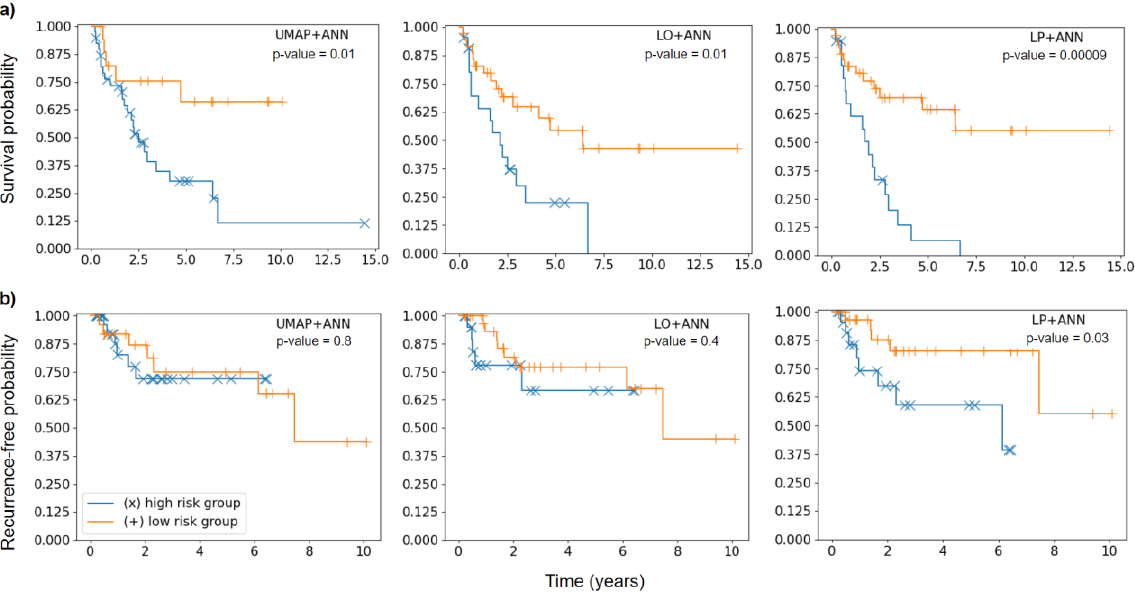
Figure 1. Kaplan-Meier curves of high-risk (blue) and low-risk (orange) patient groups separated according to a threshold optimized during cross-validation. Significance of difference was assessed using the log-rank test. ( a ) Kaplan-Meier plots for OS endpoint. ( b ) Kaplan-Meier plots for LRF endpoint.